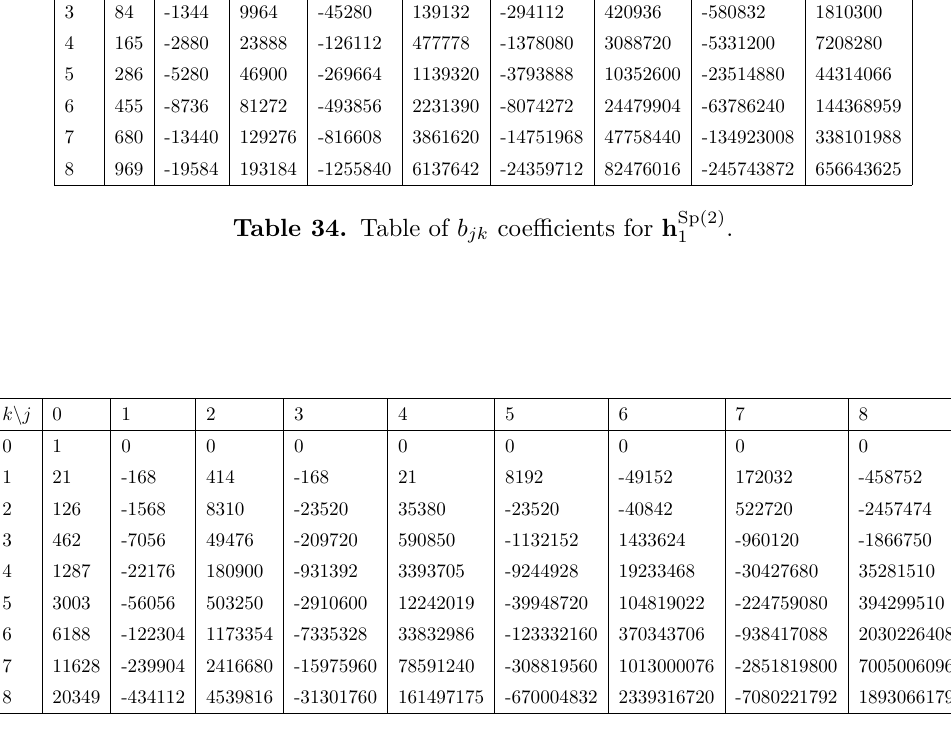
Table 35. Table of b jk coe(cid:14)cients for h Sp(3)